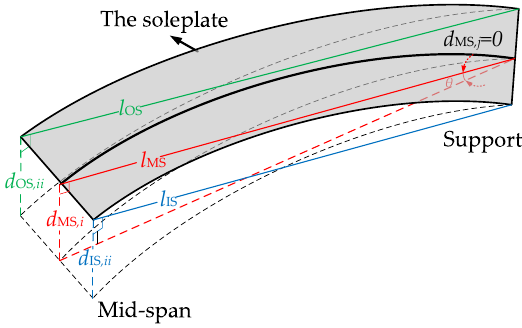
Figure 11. The in-plane bending displacements and rotational angle θ for a section.